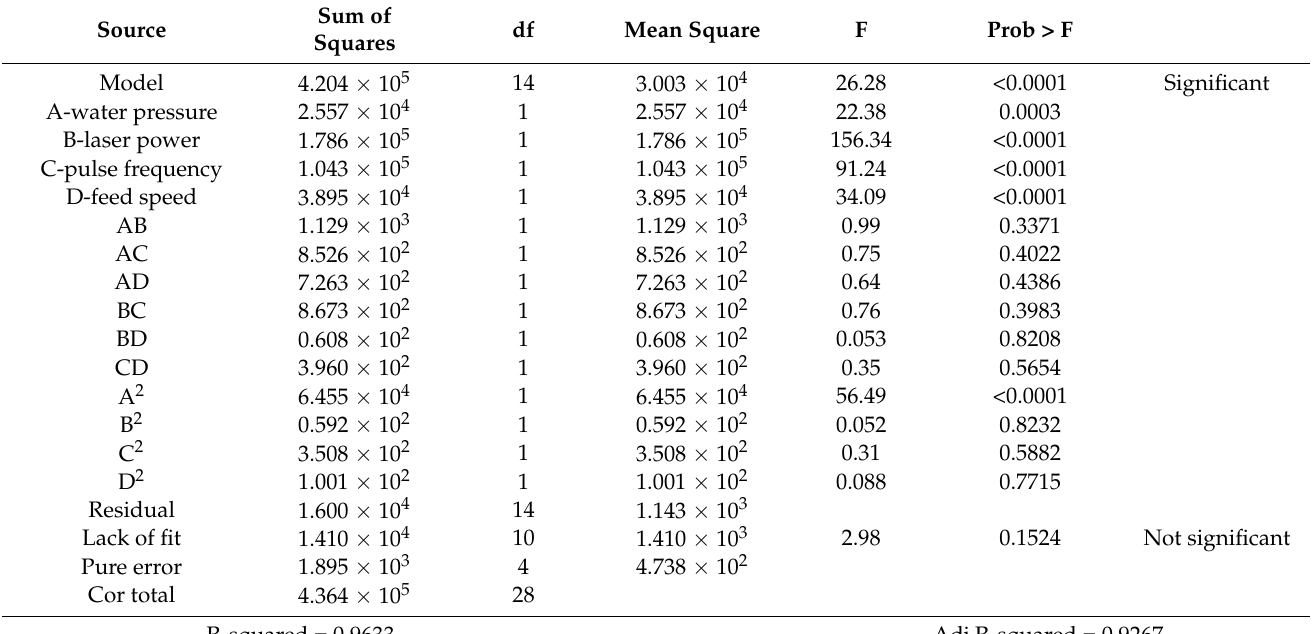
Figure 14. Residual distribution of actual value and predicted value. Table 7. Variance analysis of cutting depth regression